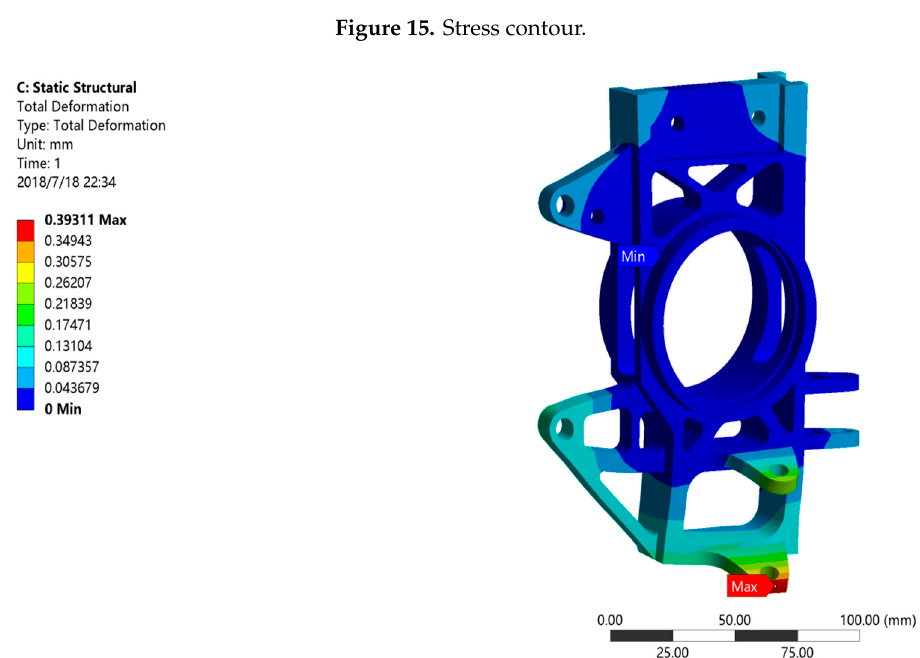
Figure 16. Deformation Figure 16. Strain cloud . 3.5.3. Analysis and verification of emergency turning conditions of front pillar.